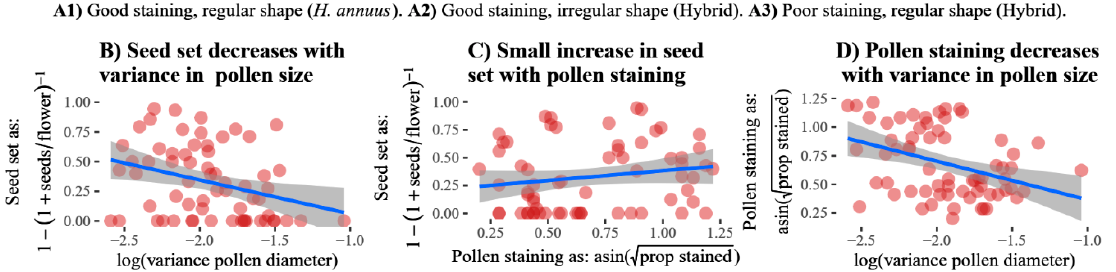
Figure 2. Fertility traits ( A ) as seen in pollen samples of H. annuus and H. annuus × H. tuberosus hybrids and ( B-D ) compared across female and male fertility